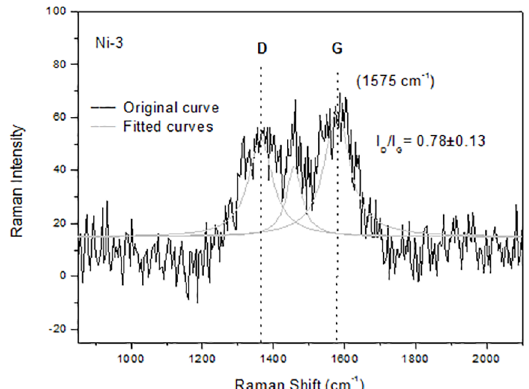
Figure 3. Raman spectrum of Ni-3